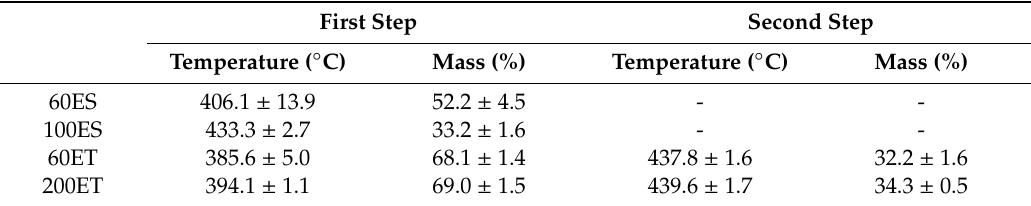
Figure 4. Thermal stability evaluations of the various PU films, showing ( a ) representative thermal gravimetric analysis (TGA) curves on percentage mass loss with onset temperatures ranged between 337 to 355 °C; and ( b ) representative dTG curves where the 60ES and 100ES groups exhibited single peak decomposition temperature and the 60ES and 200ES groups displayed a two-step decomposition process. Table 2. dTG temperatures and their corresponding percentage mass losses of the various PU films.